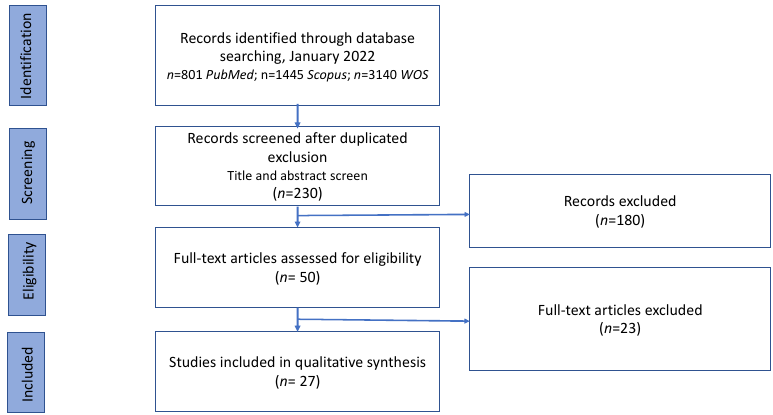
Figure 1. Flow diagram describing study selection process.